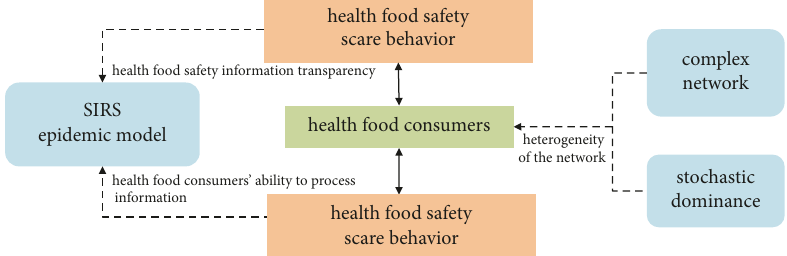
Figure 1: Technology roadmap of the